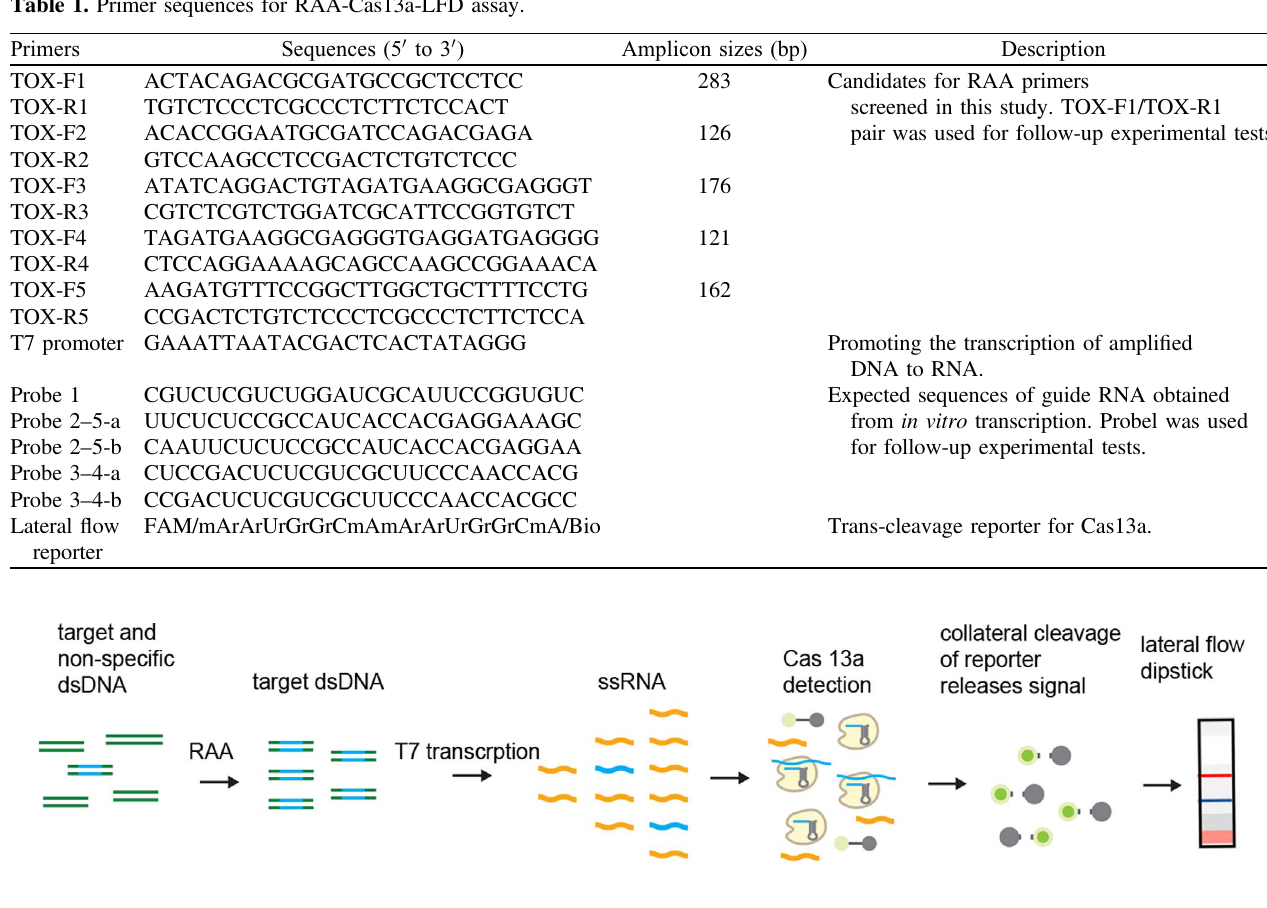
Table 1. Primer sequences for RAA-Cas13a-LFD assay.